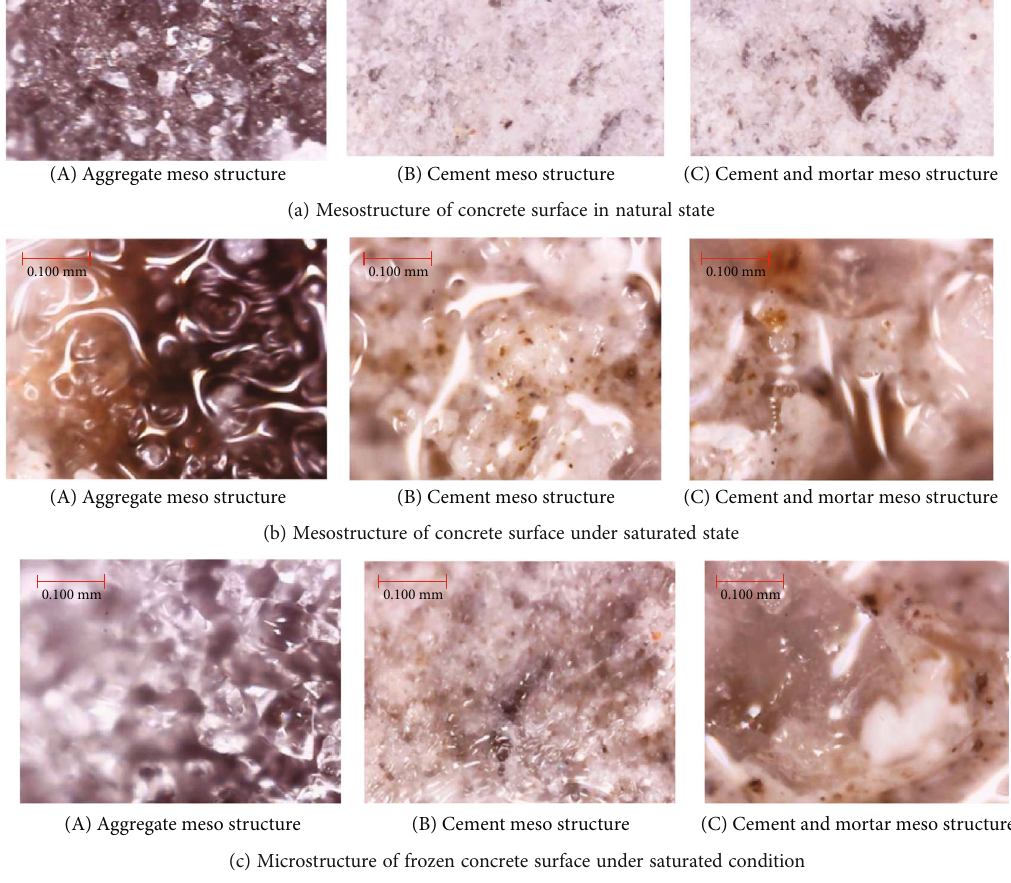
Figure 14: Failure pattern of